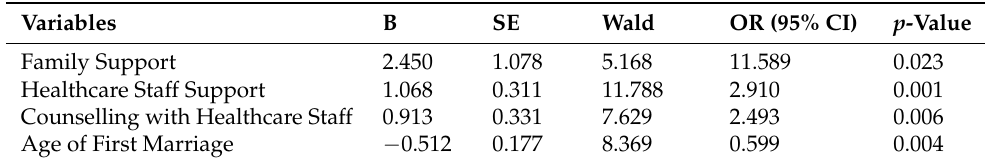
Table 4. Modelling of determinant factors on choosing post-partum contraceptives during the COVID-19